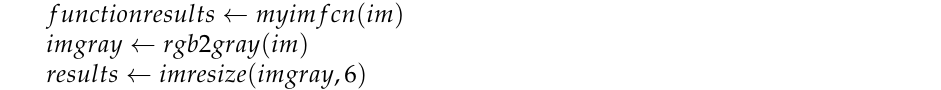
Algorithm A1: Function to convert and resize the infrared images in